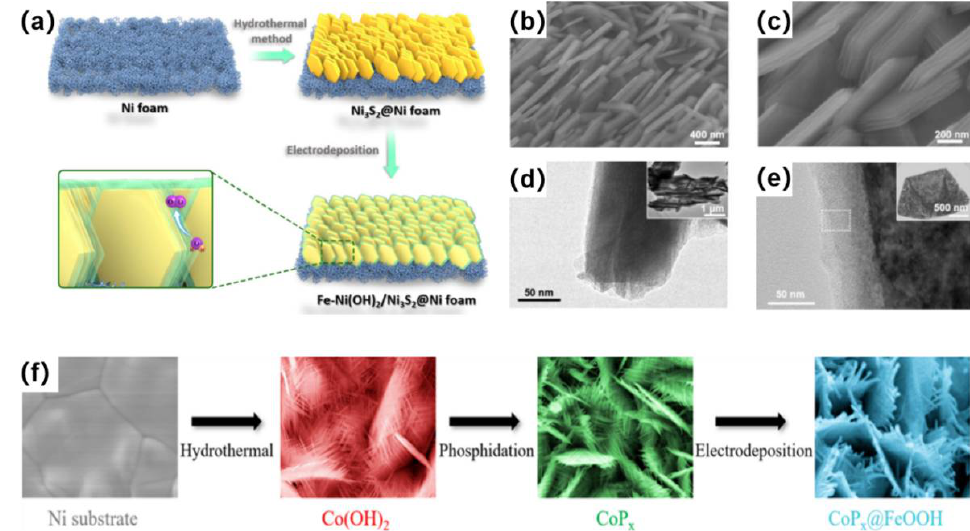
Figure 5. ( a ) Schematic illustration for the synthesis of Fe-Ni(OH) 2 /Ni 3 S 2 , ( b , c ) SEM images of Fe-Ni(OH) 2 /Ni 3 S 2 , ( d , e ) TEM images of the lateral edge at a vertical plate. Reproduced with permission from [64]. Copyright © 2020, Springer Nature, ( f ) Schematic illustration of the synthesis of CoP x @FeOOH. Reproduced with permission from [24]. Copyright © 2021, Elsevier.